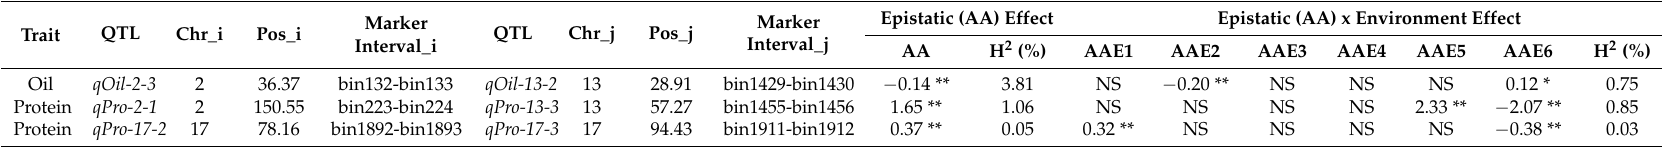
Table 4. Estimated epistatic effects (AA) and environmental (AAE) interaction of QTLs for soybean seed oil and protein contents across all environments.